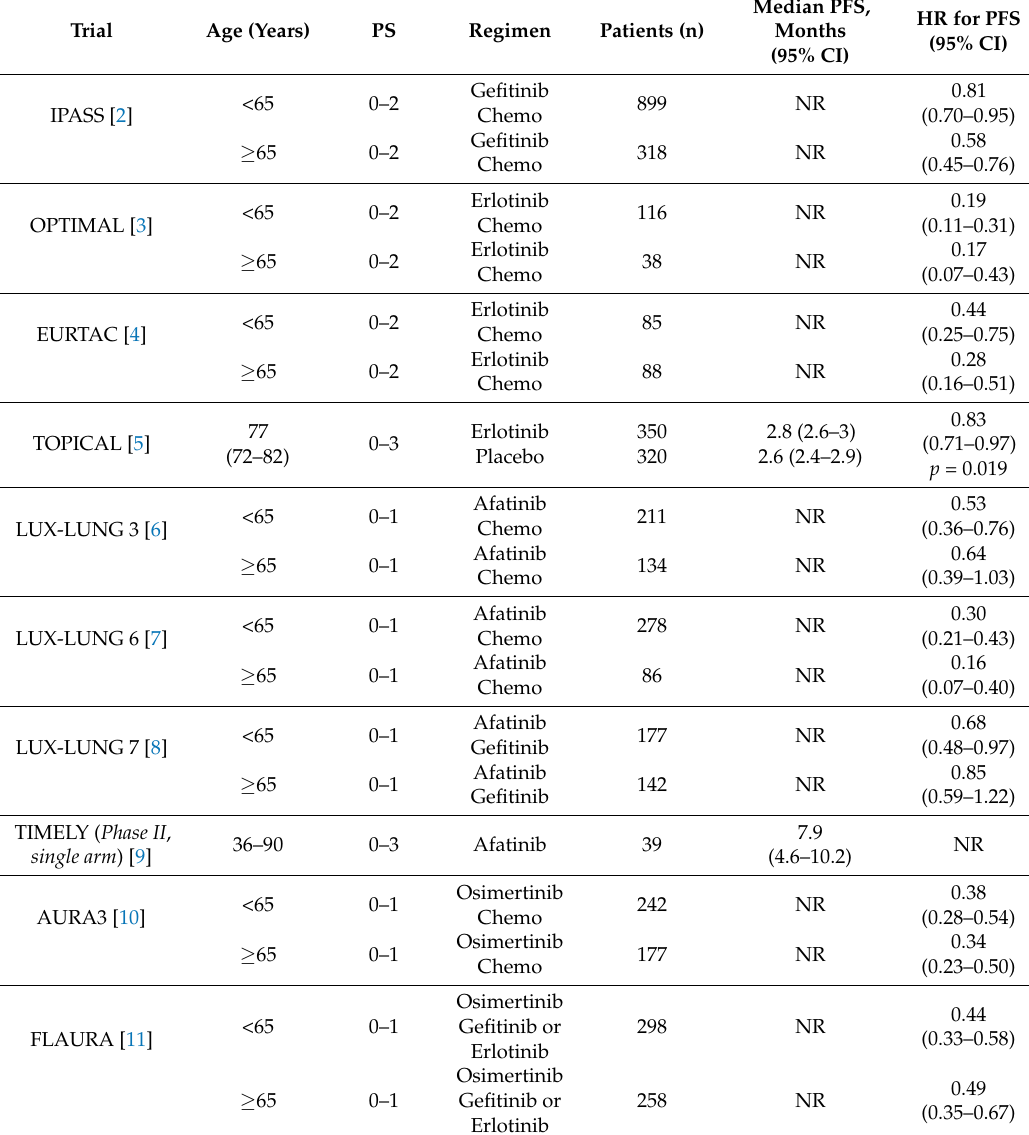
Table 1. Sub-group analyses of elderly patients in phase II/III trials of first line EGFR TKI’s in patients with advanced